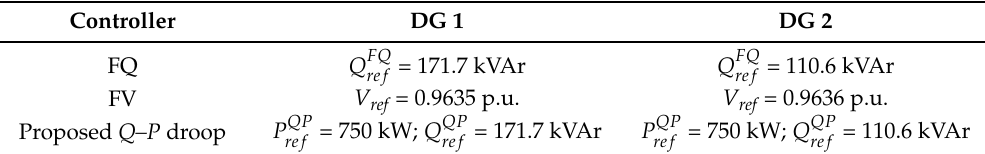
Table 2. References for Reactive Power Controllers.